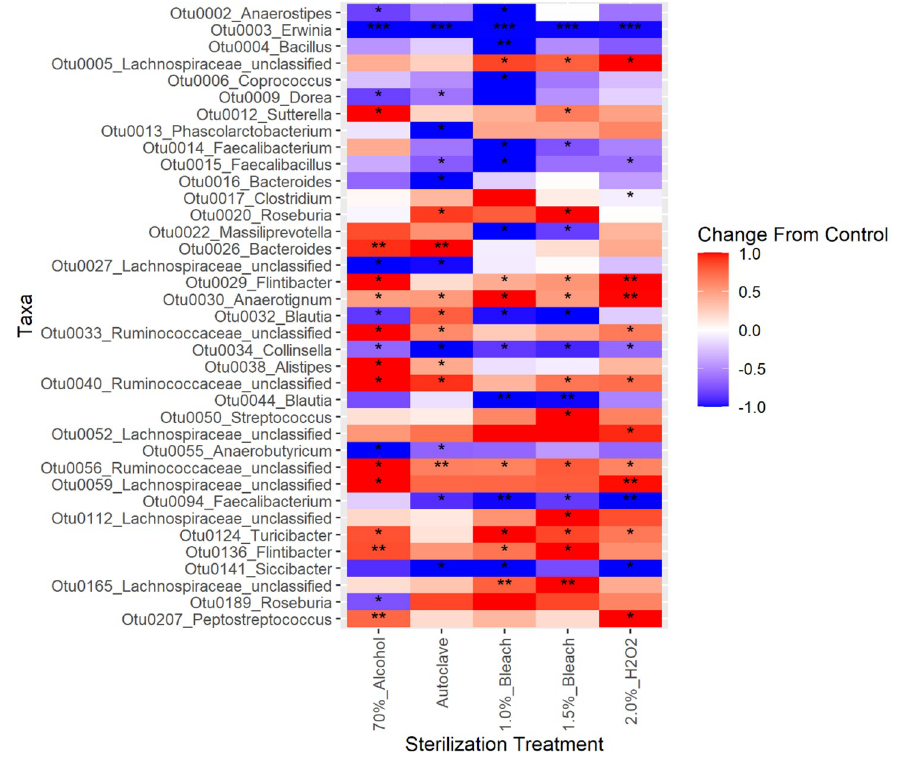
Fig 5. Heatmap of differential abundance for pulse flour treatments that have undergone 24 h simulated in vitro colonic fermentation at 37˚C. An asterisk indicates significance (FDR corrected p < 0.05) for one differential abundance test—ANCOM-II, LEfSe, or DESeq2. Two asterisks indicate significant differences as determined by two of the tests, three asterisks indicate significant differences by all three methods. Each treatment group includes all four pulse types. Red indicates an increase, while blue indicates a decrease in differential abundance. OTU0003 ( Erwinia ) is the primary microbe that changed in differential abundance by decreasing compared to unsterilized pulse flours.